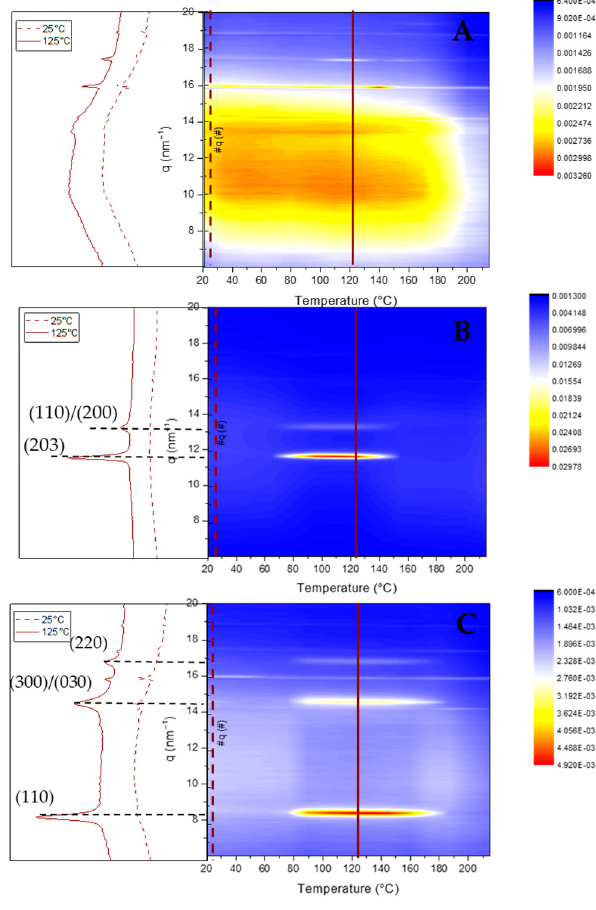
Figure 5. WAXS patterns of NP-Rac-PLA ( A ), NP-HC-PLA ( B ) and NP-SC-PLA ( C ) upon heating.